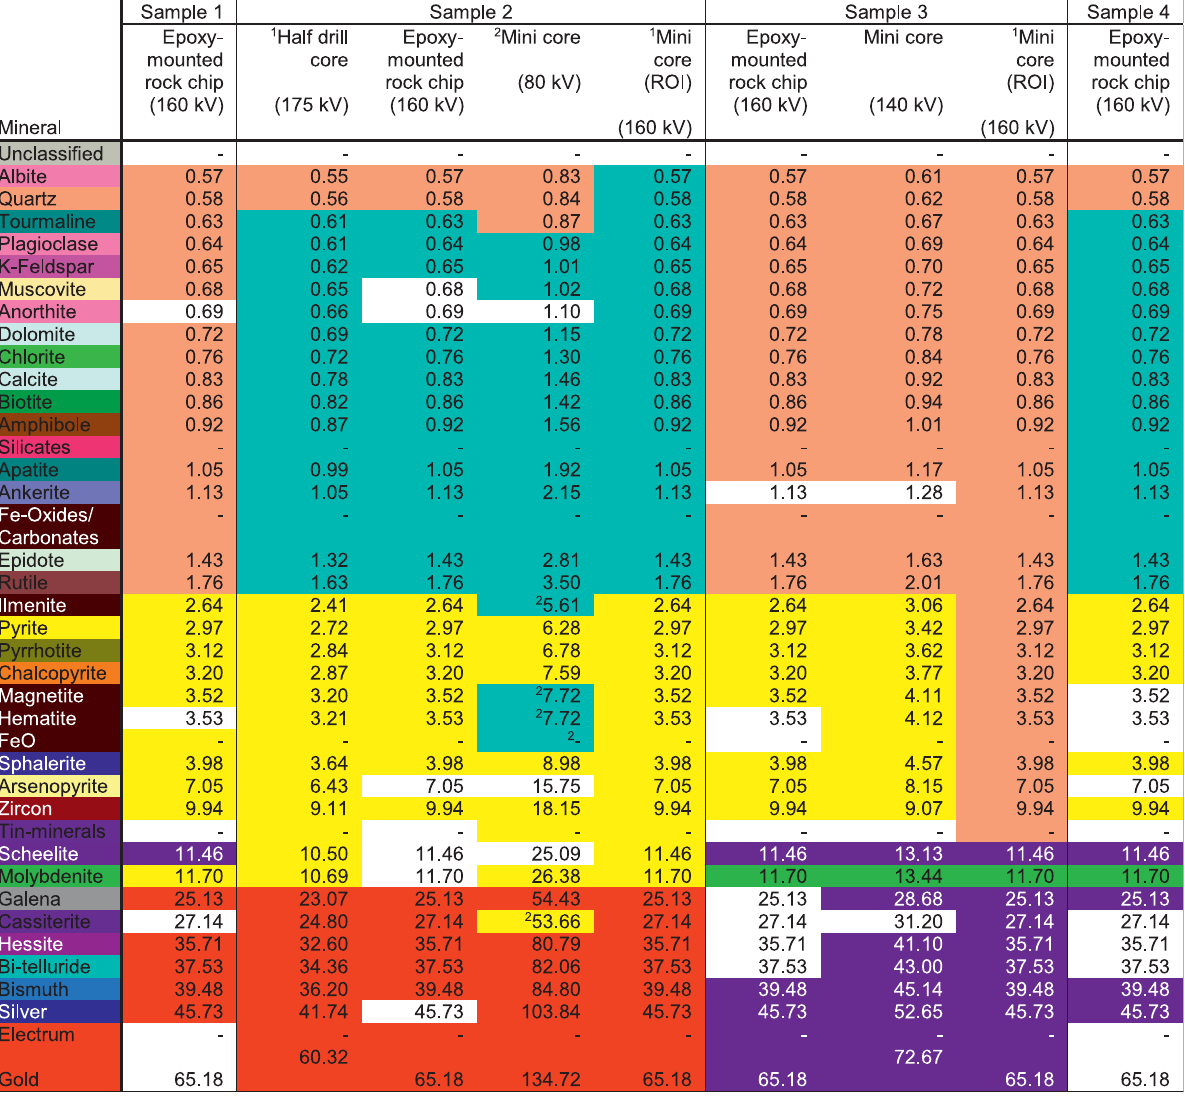
TABLE2| Listofcalculatedx-raylinearattenuationcoef fi cientsofallmineralsidenti fi edbyAMinthisstudy.Thecolorsintheleftcolumn(Mineral)refertotherespectivecolors of the minerals in the AM mineral maps. The numbers in the columns are the x-ray linear attenuation coef fi cients of the minerals for the respective beam energy of each scan (175, 160, 140 and 80 kV). The coef fi cients were calculated using the MXLAC tool (Bam et al., 2020). For mineral groups (e.g., amphiboles, epidote) one mineral was pickedtorepresentthewholegroup.Forbroadgroups(e.g.,silicates,Fe-oxides/carbonates)novalueswerecalculated.TheXCTdataweresegmentedintoclasses(mineral groups) based on a combination of grey-scale thresholding and an edge intensity fi lter. To determine the minerals comprising each segmented class, the data were visually compared with the AM mineral maps. Each mineral from the original AM maps was then appointed to its corresponding class (mineral group) in the segmented XCTdataandsimpli fi edAMmineralmapscreated.FormineralswherevisualcomparisonoftheAMandXCTdatawasinconclusivetoappointittoaclass,thecalculated x-ray linear attenuation coef fi cient relative to that of the other minerals was used as reference. Color coding of the cells with numbers represents the simpli fi cation of the AM quantitative maps for correlation with the segmented XCT data. Uncolored cells indicate that the minerals were not present in the respective AM maps. Variable contrast between minerals in the XCT data due to variable beam energies, tomographic reconstruction, and beam hardening correction between XCT scans is the reason for the differences in mineralogy of the segmented classes between